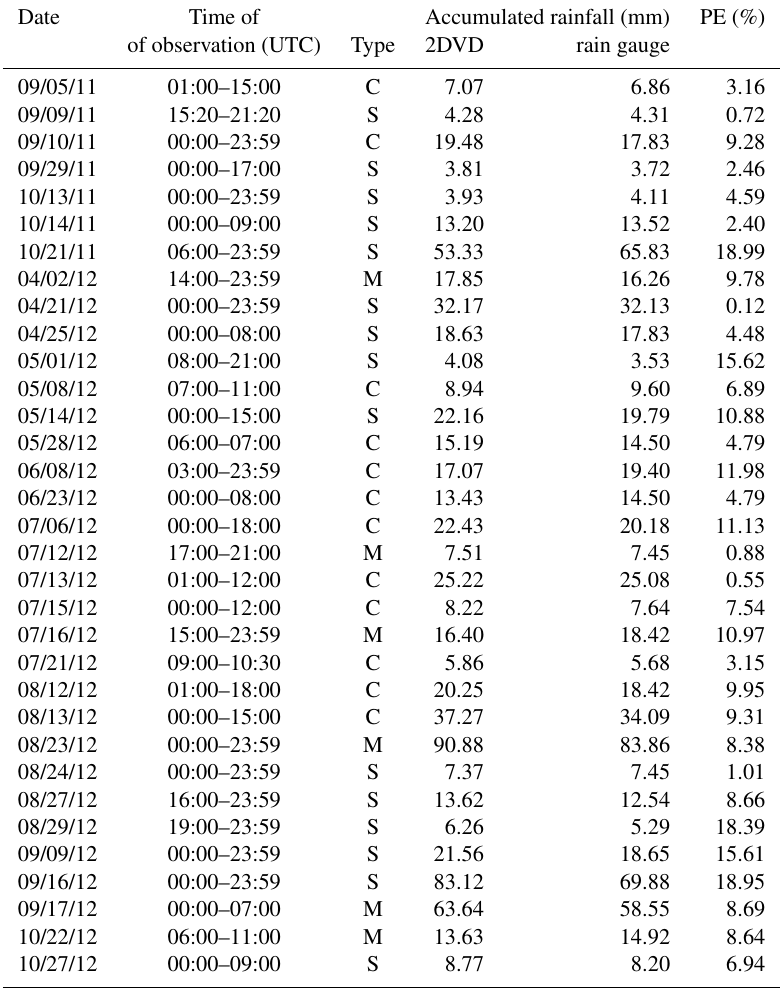
Table 2. Summary of the date, type of precipitation, and accumulated rainfall comparison values between 2DVD and rain gauge measure- ments for the 33 rainfall